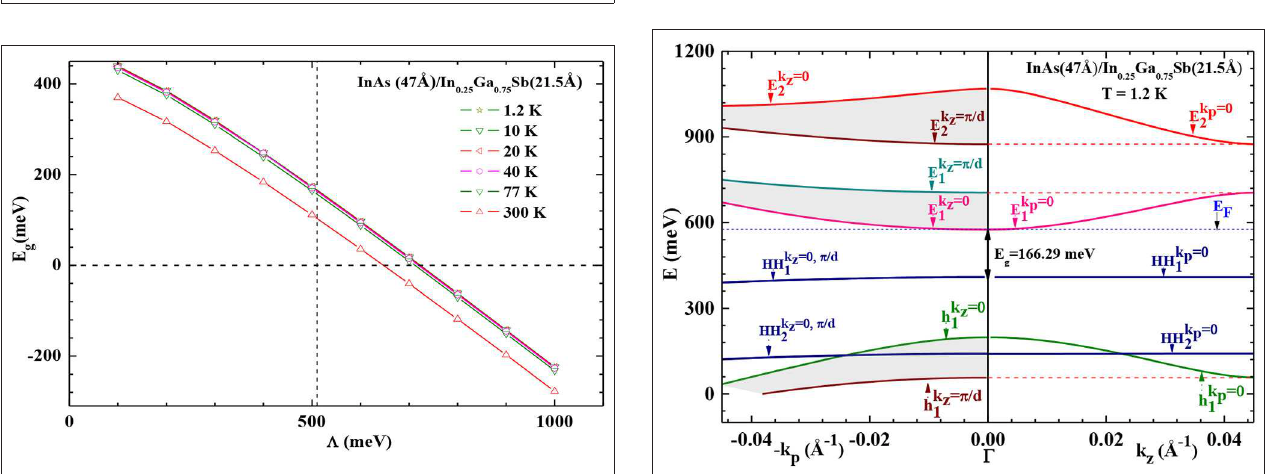
FIGURE 5 | Band structures of the investigated SL along the k z and k p